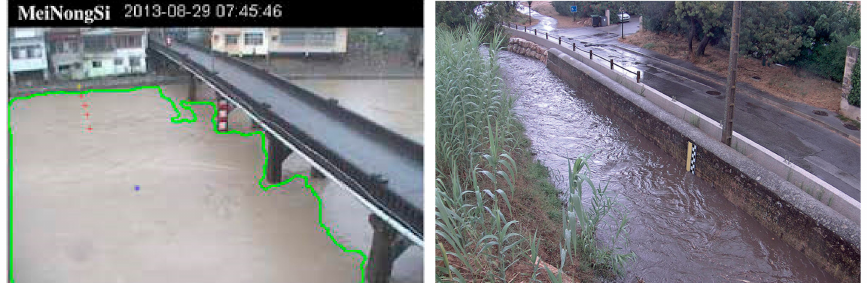
Figure 4. Visual sensing ( left ) [100] and water level detection ( right ), it becomes possible to detect the real-time water level [101].